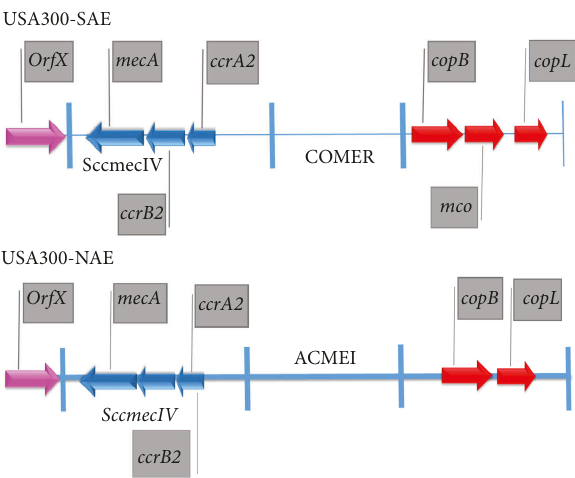
Figure 1: Location of copB (X) and copL genes in NAE-USA300 and